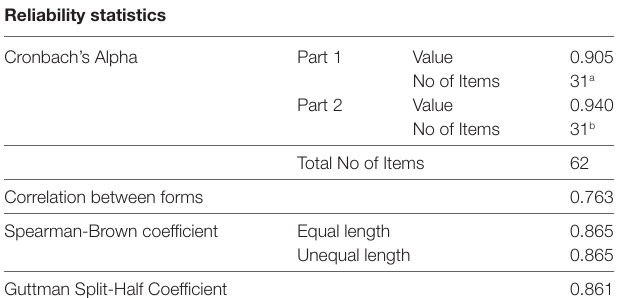
TaBle a5 | Split-half correlations of ASES Final